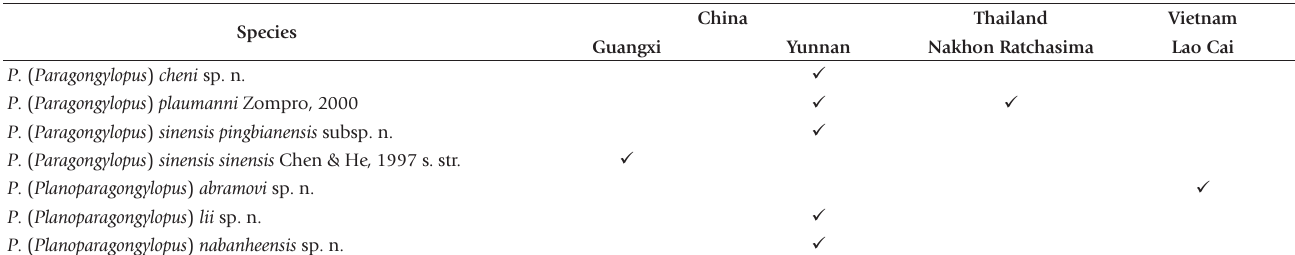
Table 1. Distribution of Paragongylopus ( Paragongylopus ) Chen & He, 1997 s. str. and P . ( Planoparagongylopus ) subgen. n.